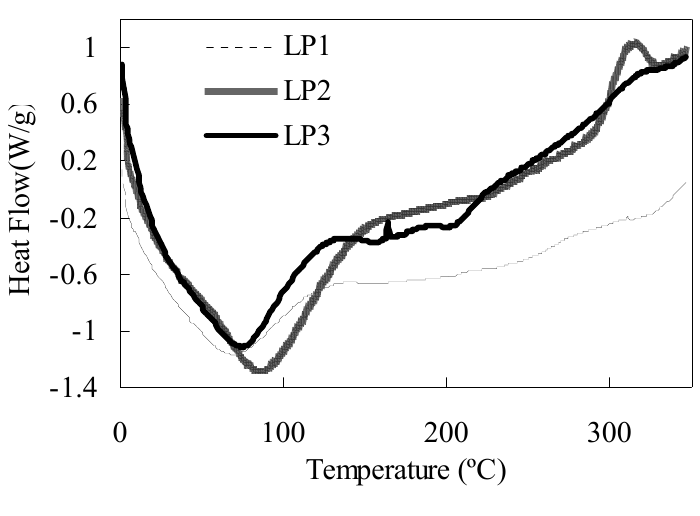
Figure 4. DSC curves of